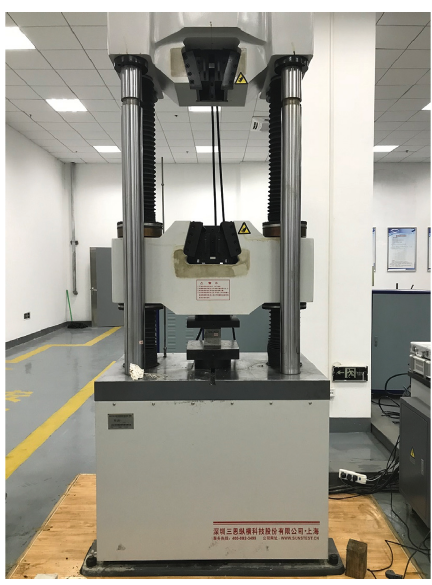
Figure 2: Test loading apparatus.